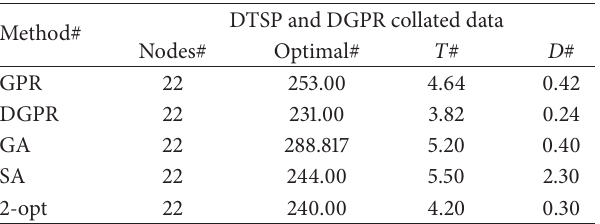
Table 1: The extracted data is collated to show forth variations in different methods.